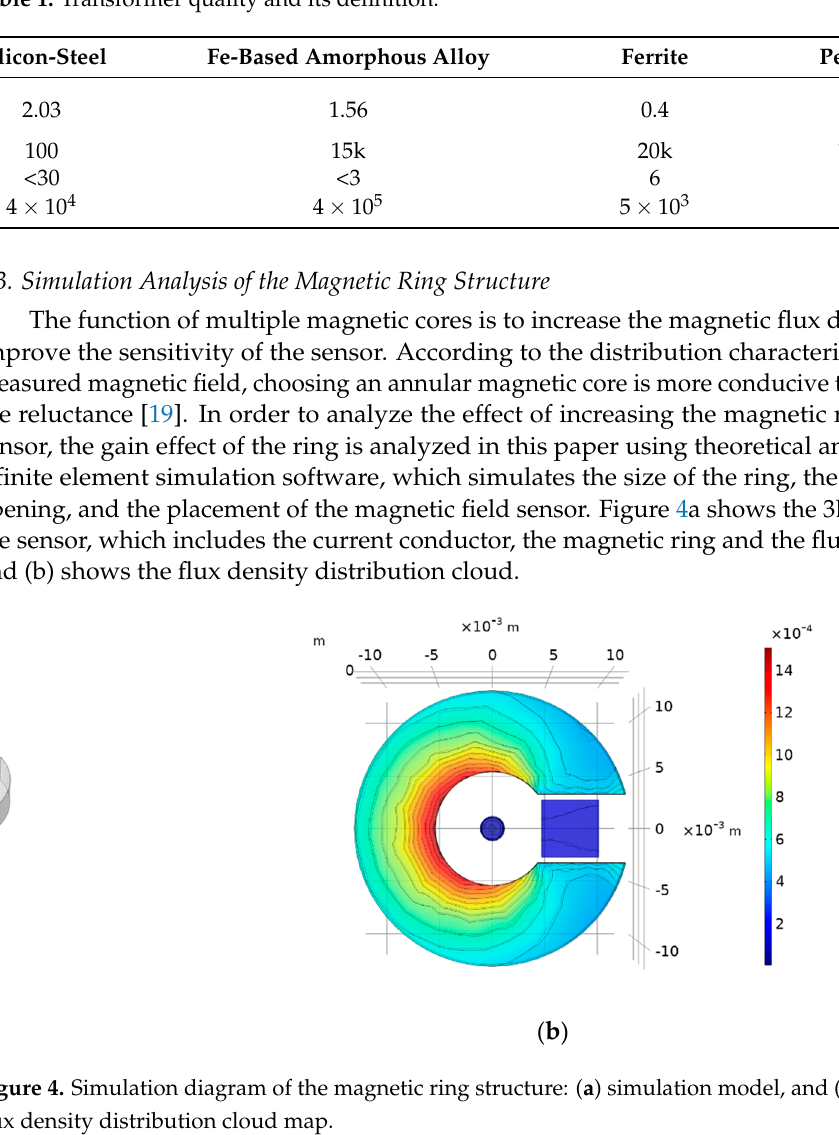
Table 1. Transformer quality and its definition.